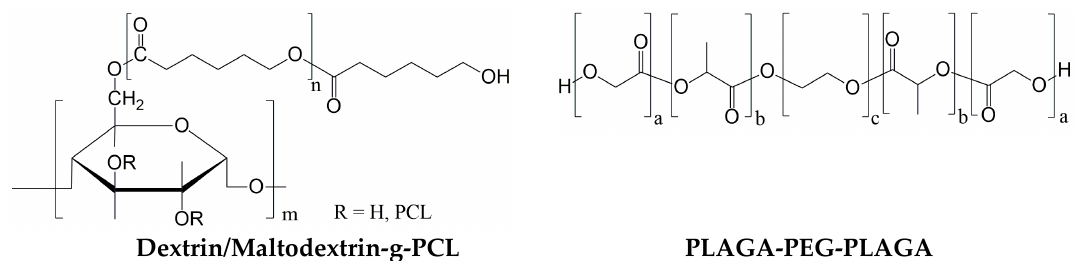
Figure 1. Schematic structures of synthesized polymers.